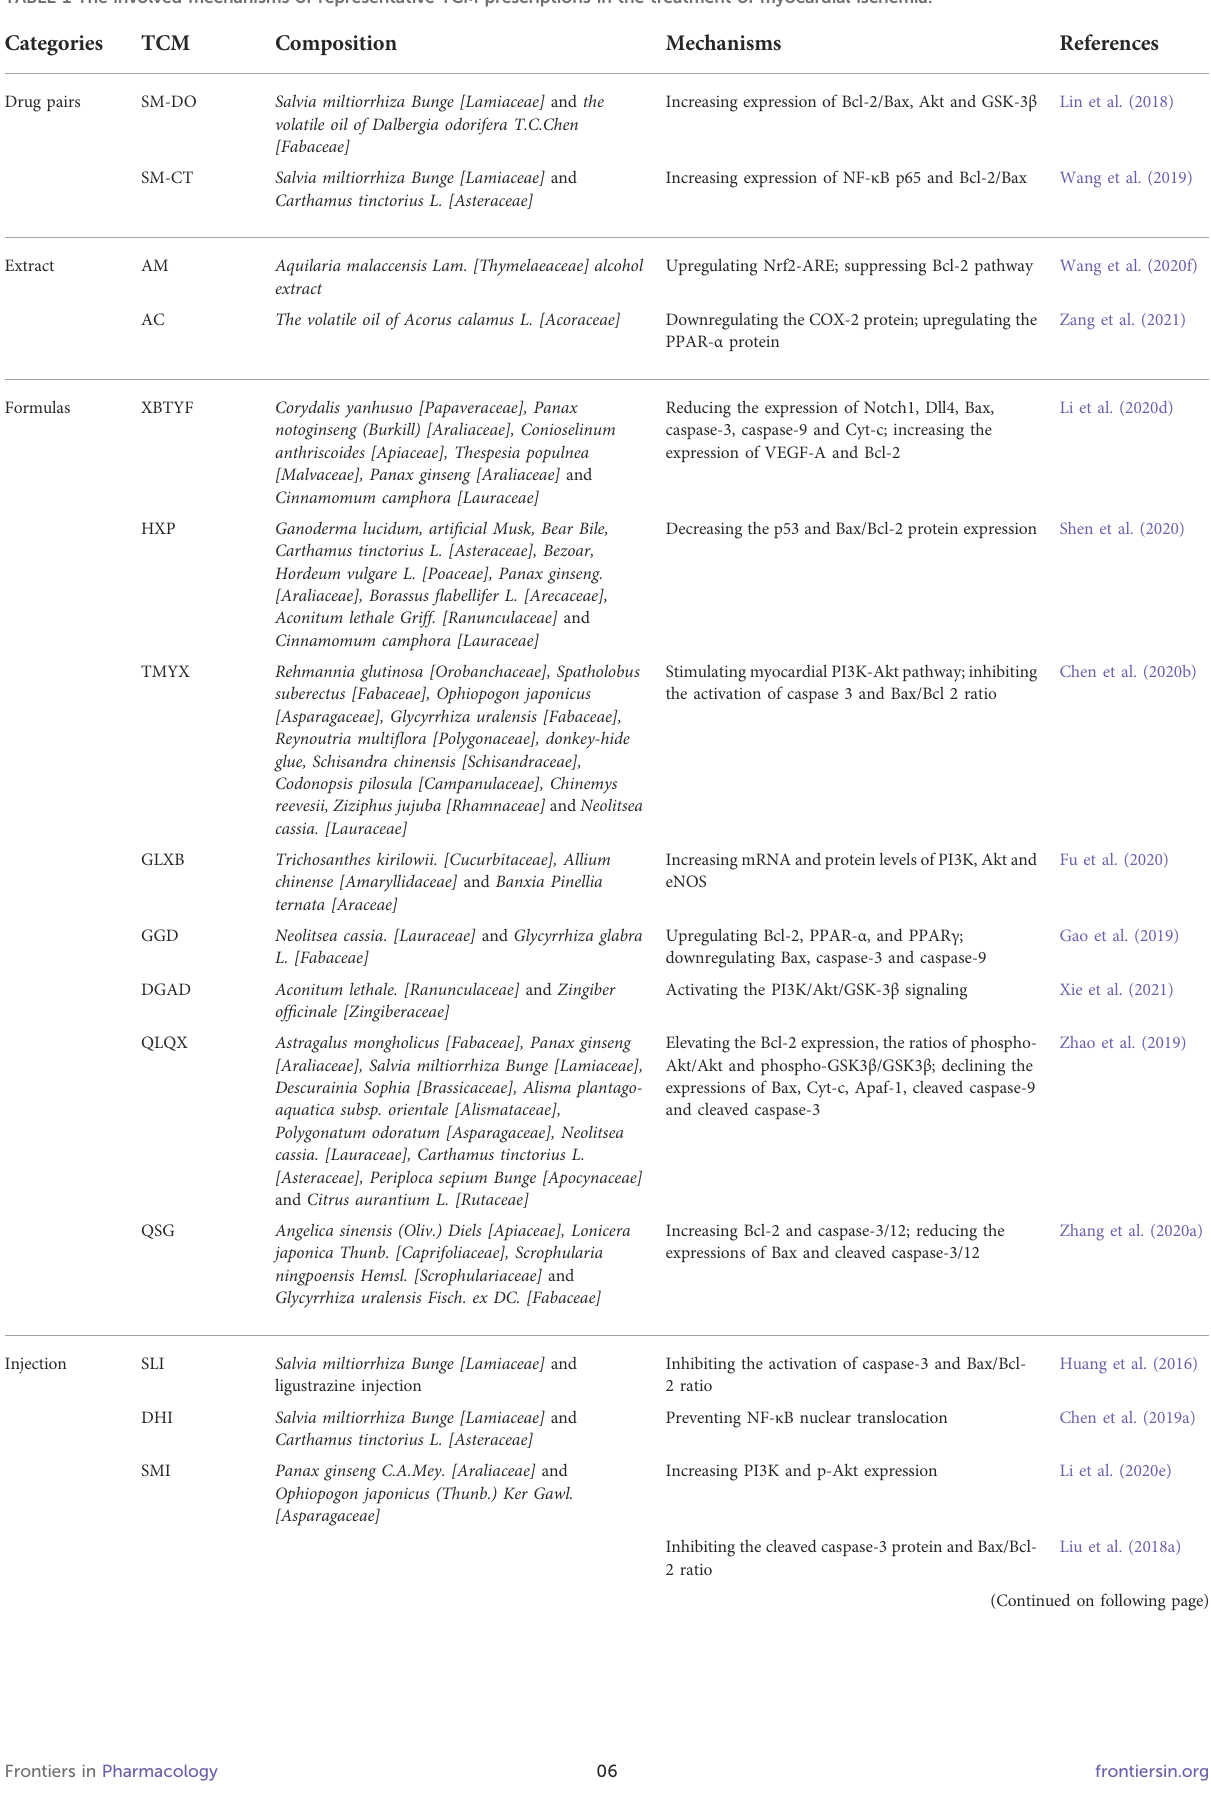
TABLE 1 The involved mechanisms of representative TCM prescriptions in the treatment of myocardial ischemia.